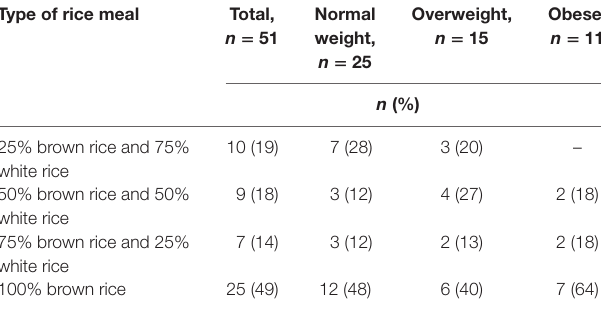
TaBle 5 | Participants postfeeding meal preference. Type of rice meal